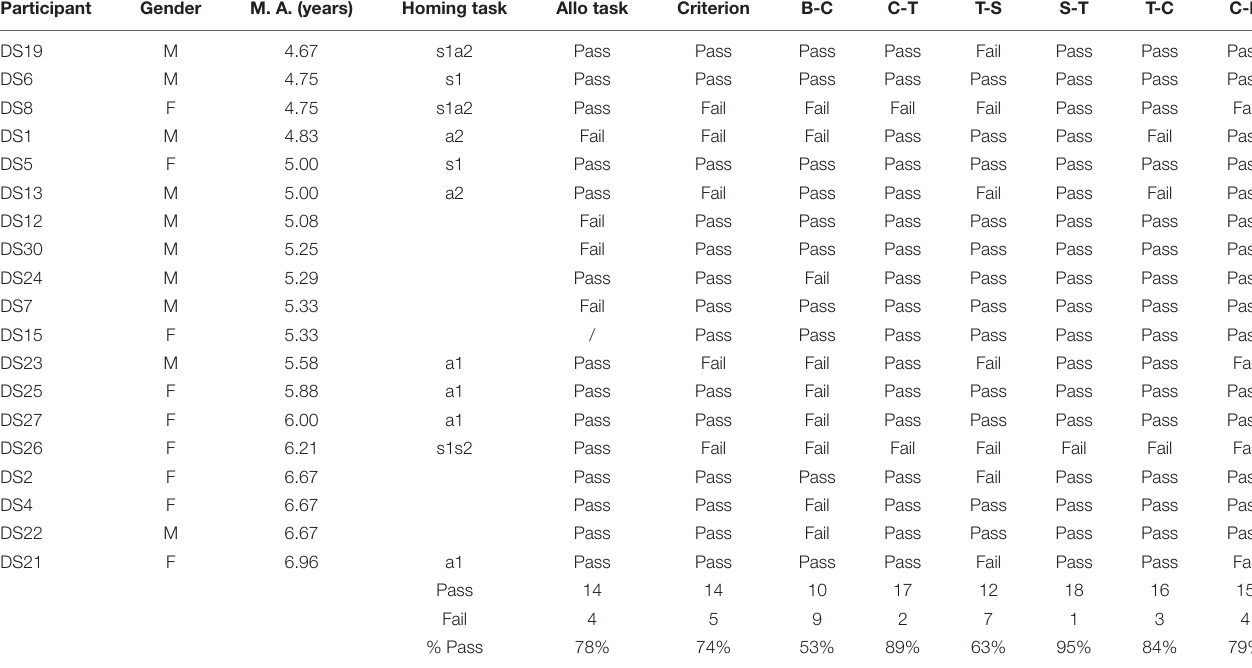
TABLE 7 | Individual performance of participants with DS for the never traveled trajectories of the cognitive mapping task. Participant Gender M. A. (years) Homing task Allo task Criterion B-C